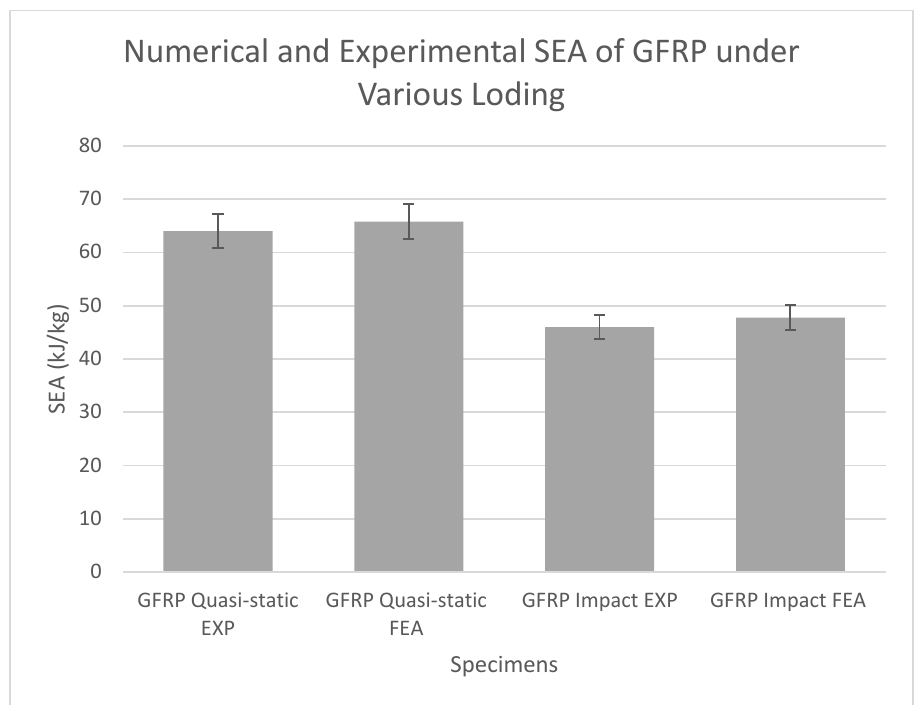
Figure 29. Numerical and experimental SEA of GFRP under Quasi-static and Impact loading con- ditions [66].